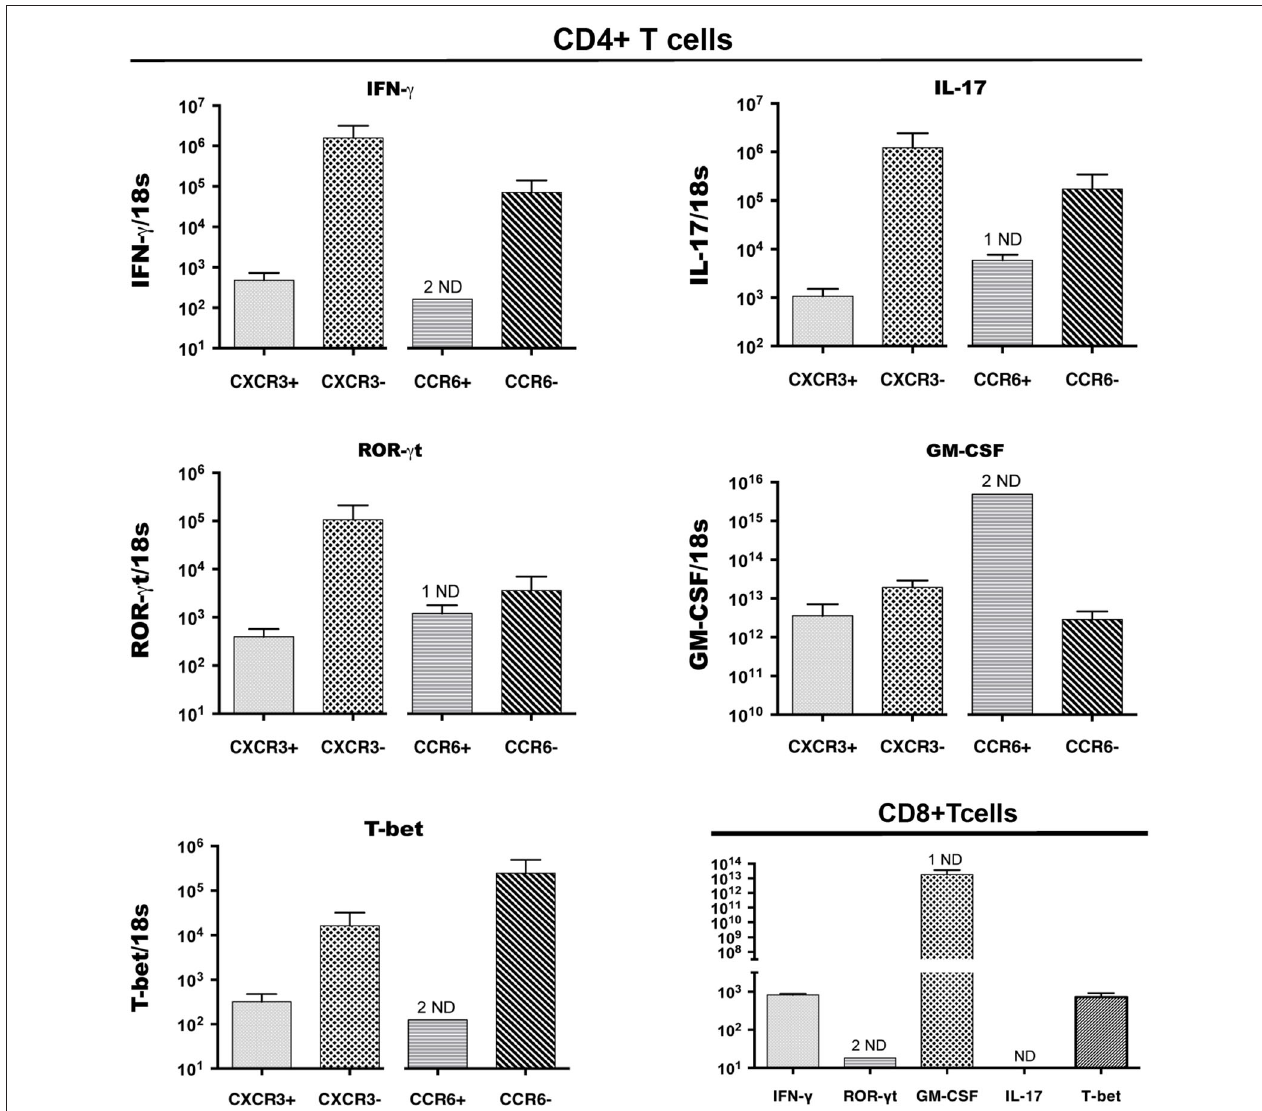
as receptor-negative CD4 + T cells from the same sorts (Top 4 and bottom left panels). Bottom right panel: CD8 + T cells in the CNS expressed IFN γ , GM-CSF, ROR γ t, Tbet mRNA, but not IL-17. The y axis shows relative levels of expression (compared to a standard curve) as a ratio to 18S rRNA levels in the same sample. ND: not detectable (1 indicates 1 sample only